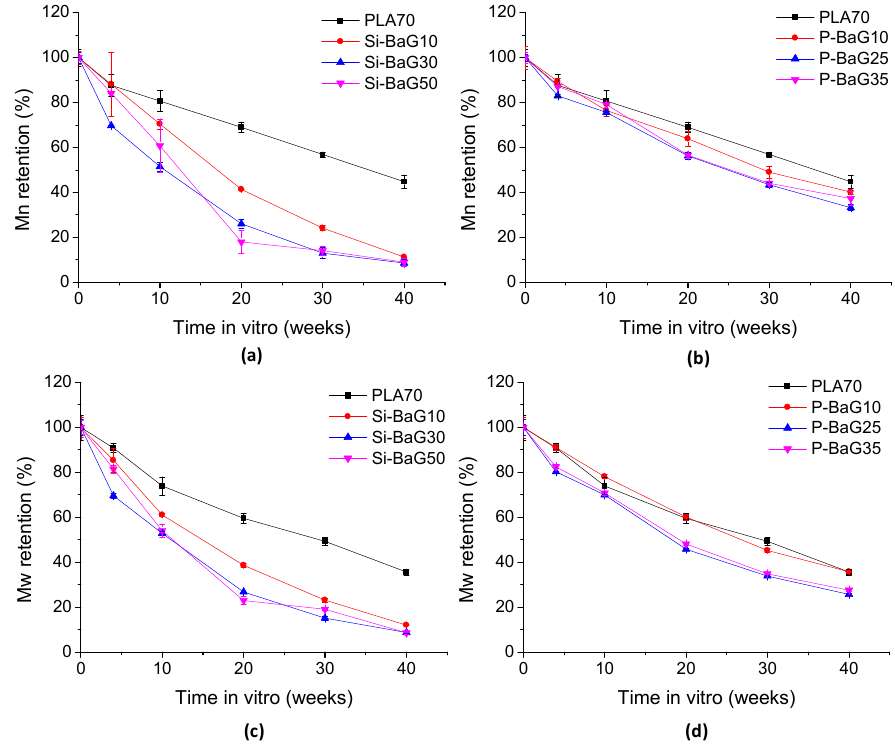
Figure 8. M n retention of PLA70 with ( a ) Si-BaG and ( b ) P-BaG and M w retention of PLA70 with ( c ) Si-BaG and ( d ) P-BaG during the in vitro hydrolysis of 40 weeks in